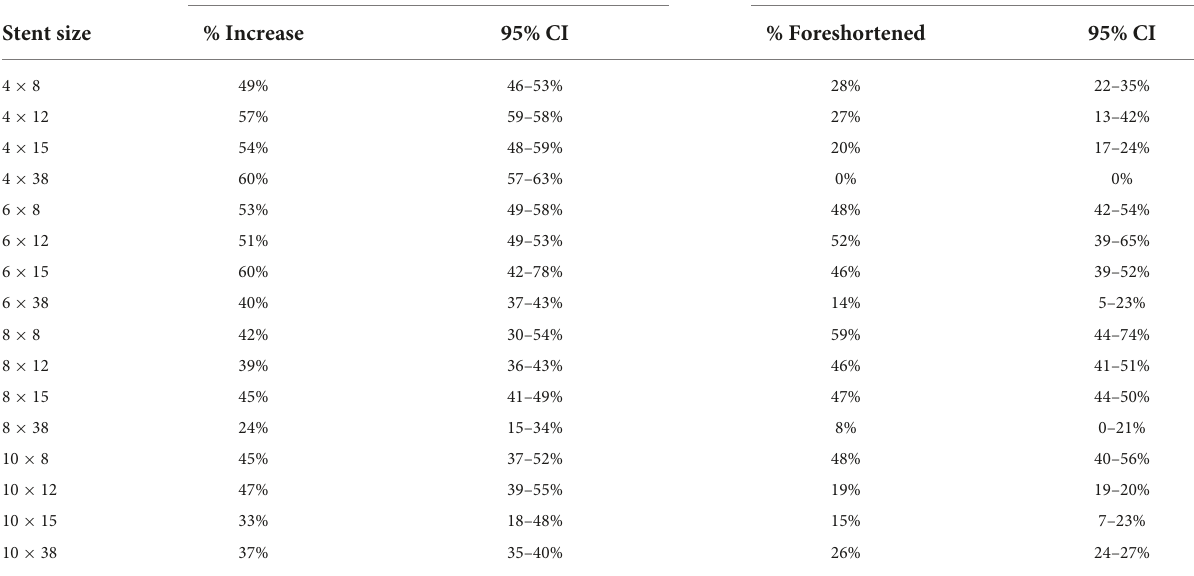
TABLE 3 Percent increase in stent diameter and percent foreshortening at time of first strut fracture. Diameter % increase at time of